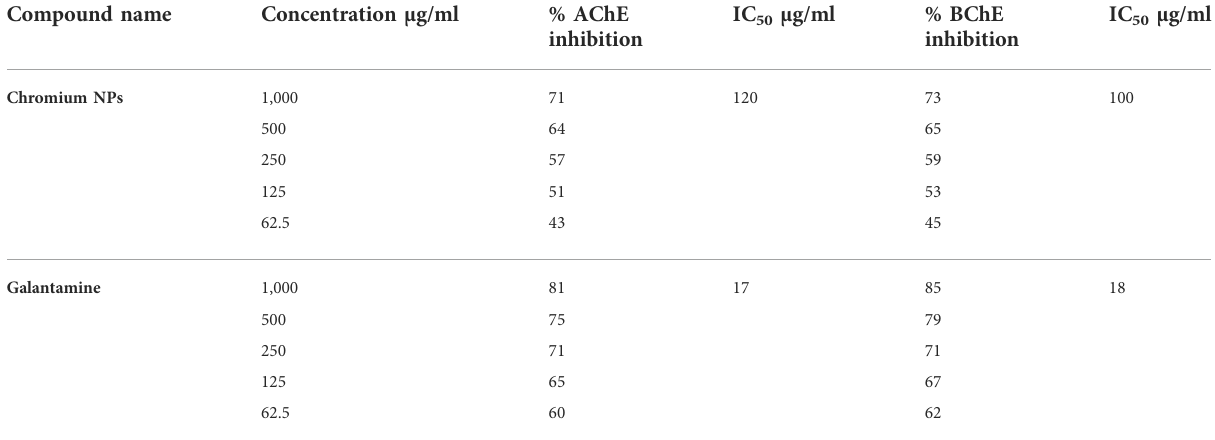
TABLE 1 Anti-cholinesterase inhibitory potential of chromium NPs compared with galantamine used as a